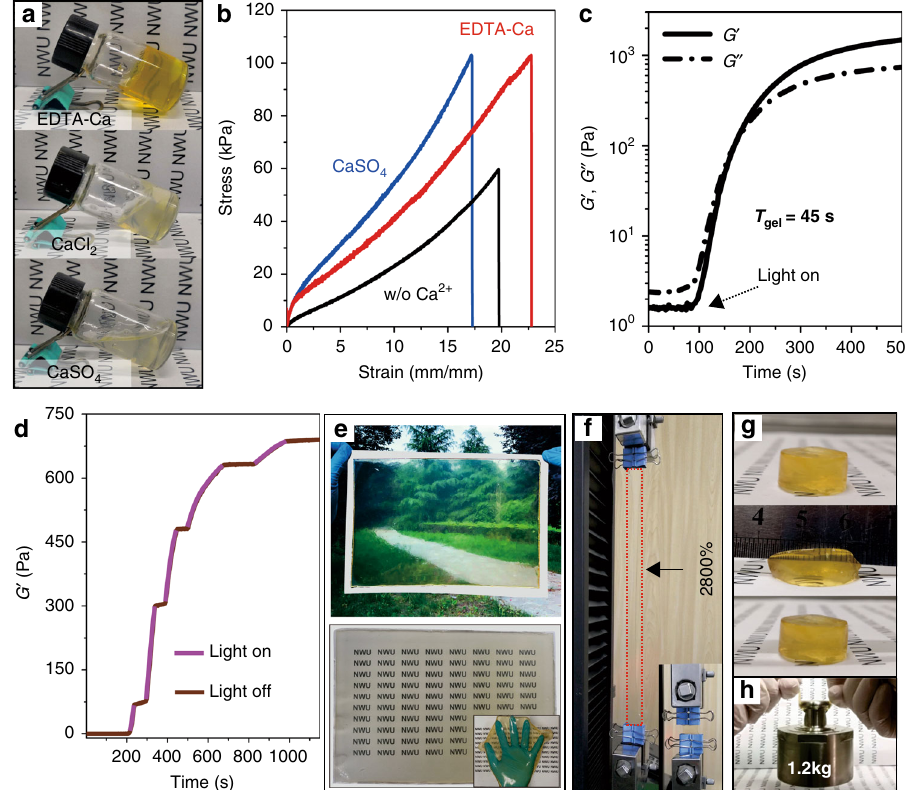
Fig. 2 The formation mechanism of THVMD hydrogels. a Pure alginate hydrogels with different Ca 2 + sources. [ALG] in all samples is 2.25 wt%. [EDTA- Ca] = 50 mM, [S 2 O 8 2 − ] = 131 mM, [Ru(II)] = 31.2 µ M, 60 s irradiation at the intensity of 15 mWcm − 2 ; [CaCl 2 ] = [CaSO 4 ] = 50 mM, 60 s waiting time. b Stress-strain curves of the PAAm hydrogel and tough hydrogels without Ph – N networks. [AAm] = 2.54 M, [MBA] = 0.7 mM. Concentrations of the other components used in these cases are the same as that in a . c Real-time in situ rheology of the hydrogel precursor upon continuous light irradiation. d Storage modulus (G ′ ) measured with intermittent light irradiation. e The THVMD hydrogel fi lm with a size of 13.5 inches on A4 PET and paper sheets. The inset shows the soft fi lm peeled from the PET substrate. f , g Stretched, compressed hydrogels, and its ribbon bearing a weight of 1.2 kg,